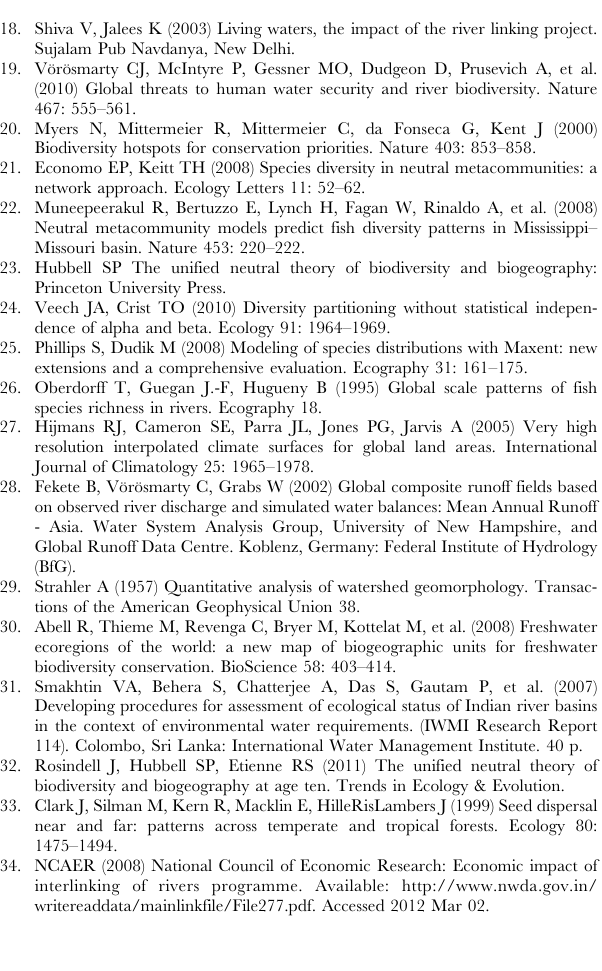
Table S1 References used to develop our database of freshwater fish species